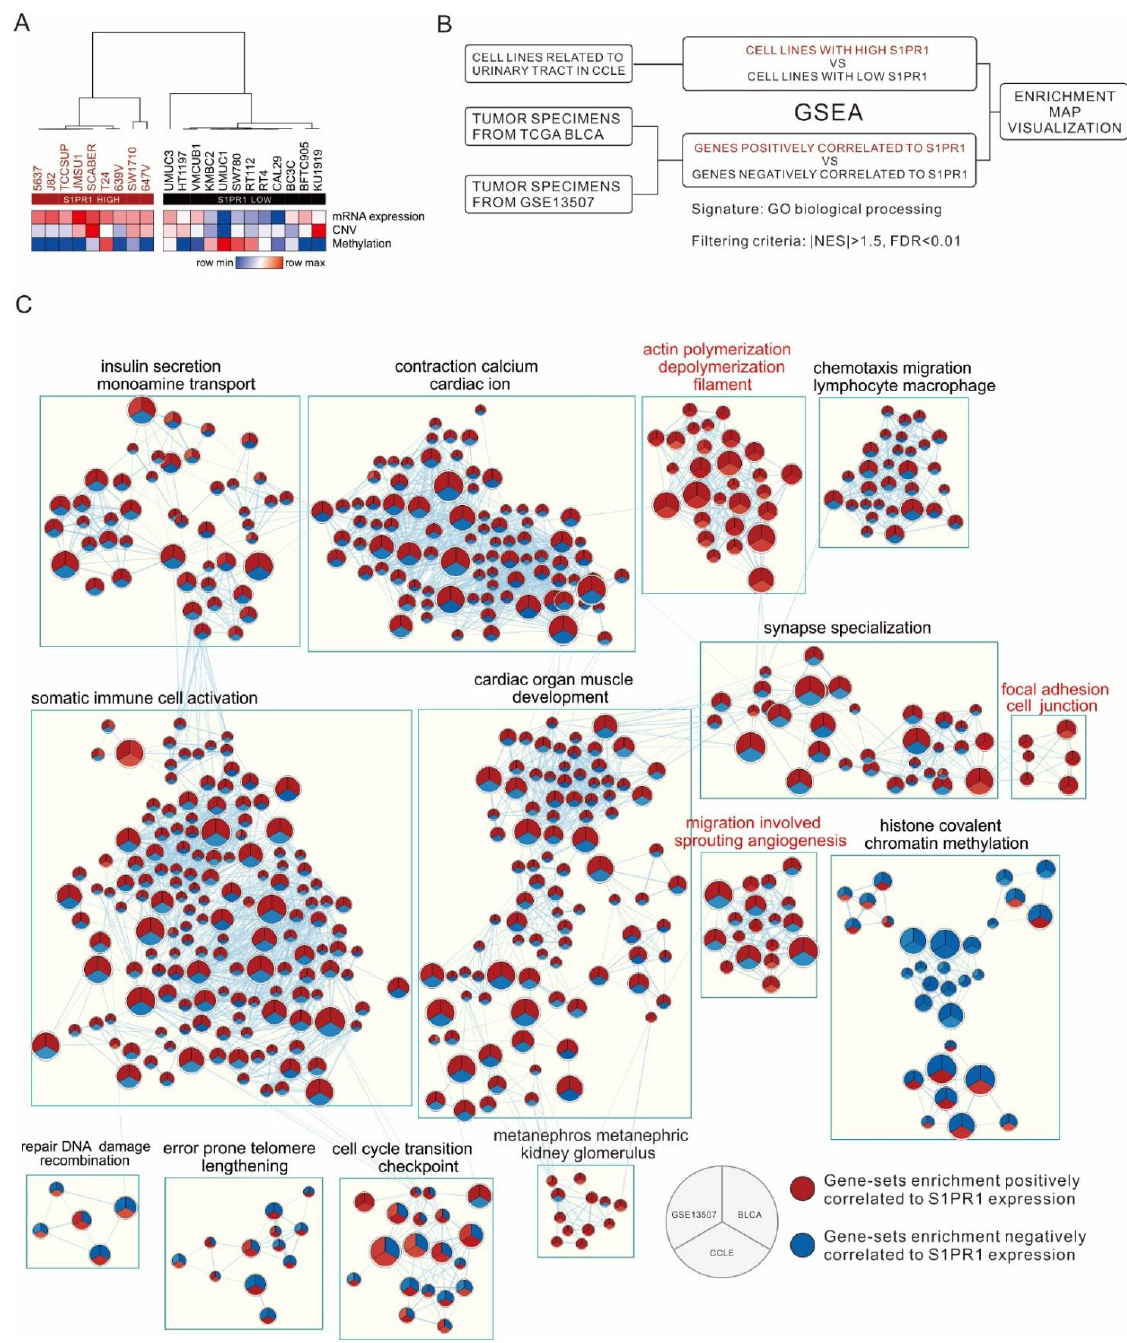
Figure 5. Investigation of S1PR1 expression in bladder cancer cells for authentic biological response enrichment associations. ( A ) Heat map demonstrating S1PR1 mRNA expression (fragments per kilobase per million, FPKM), copy number variation (log value), and methylation ( β value) of 21 uroepithelial carcinomas in the CCLE database with unsupervised hierarchical clustering. ( B ) Flow chart presenting comparison of S1PR1 expression and biological response association in CCLE bladder cancer cell lines or clinical bladder cancer tumors (TCGA BLCA, GSE13057). ( C ) Enrichment map visualization showing the GSEA scores of gene-sets significantly enriched in ( B ). The color represents the degree of normalized enrichment score (NES); red means the gene-sets are enriched in high S1PR1 samples (NES > 1.5) and blue means the gene-sets are enriched in low S1PR1 samples (NES < − 1.5). All presented enriched gene sets have passed the screening criteria of p- value < 0.05, FDR < 0.01. Gene-sets without edge linkage were excluded to increase the ease of visualization of the results.